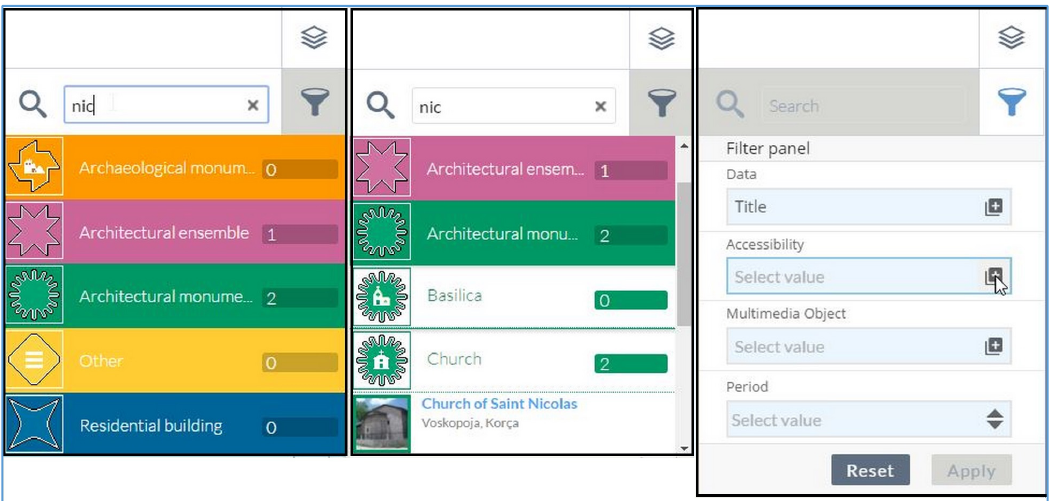
Figure 10. The interactive map— Dynamic legend with meters showing the number of PoIs according to the search results for “nic” ( left ); the legend opened at PoI level ( centre ); filter panel ( right ). These constraints limit the total number of different categories to five. However, this is not a problem because having more than five colours at a time causes colour trouble instead of reducing ambiguity [12].